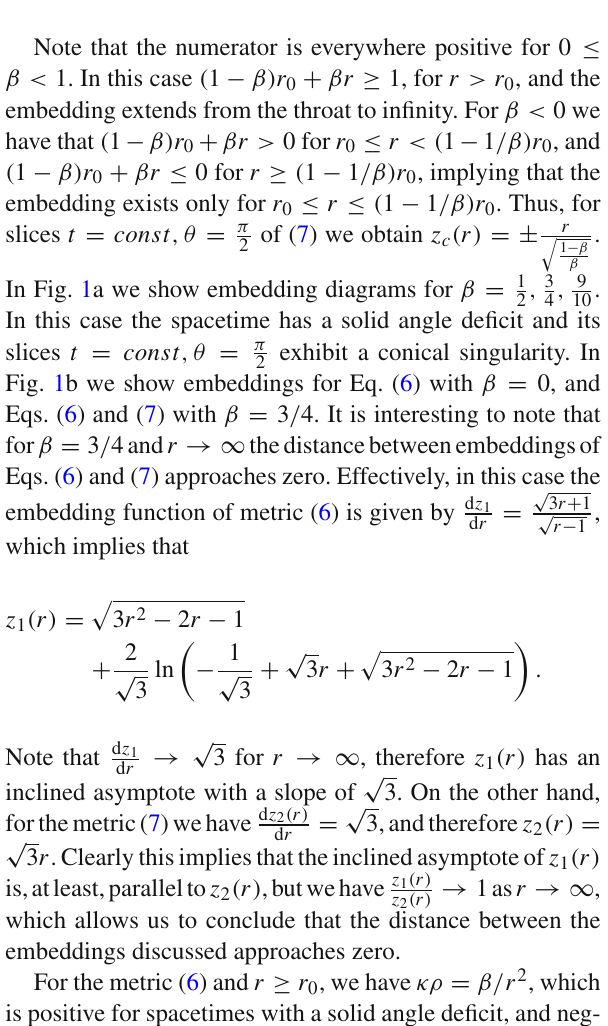
Note that the numerator is everywhere positive for 0 ≤ β < 1. In this case ( 1 − β) r